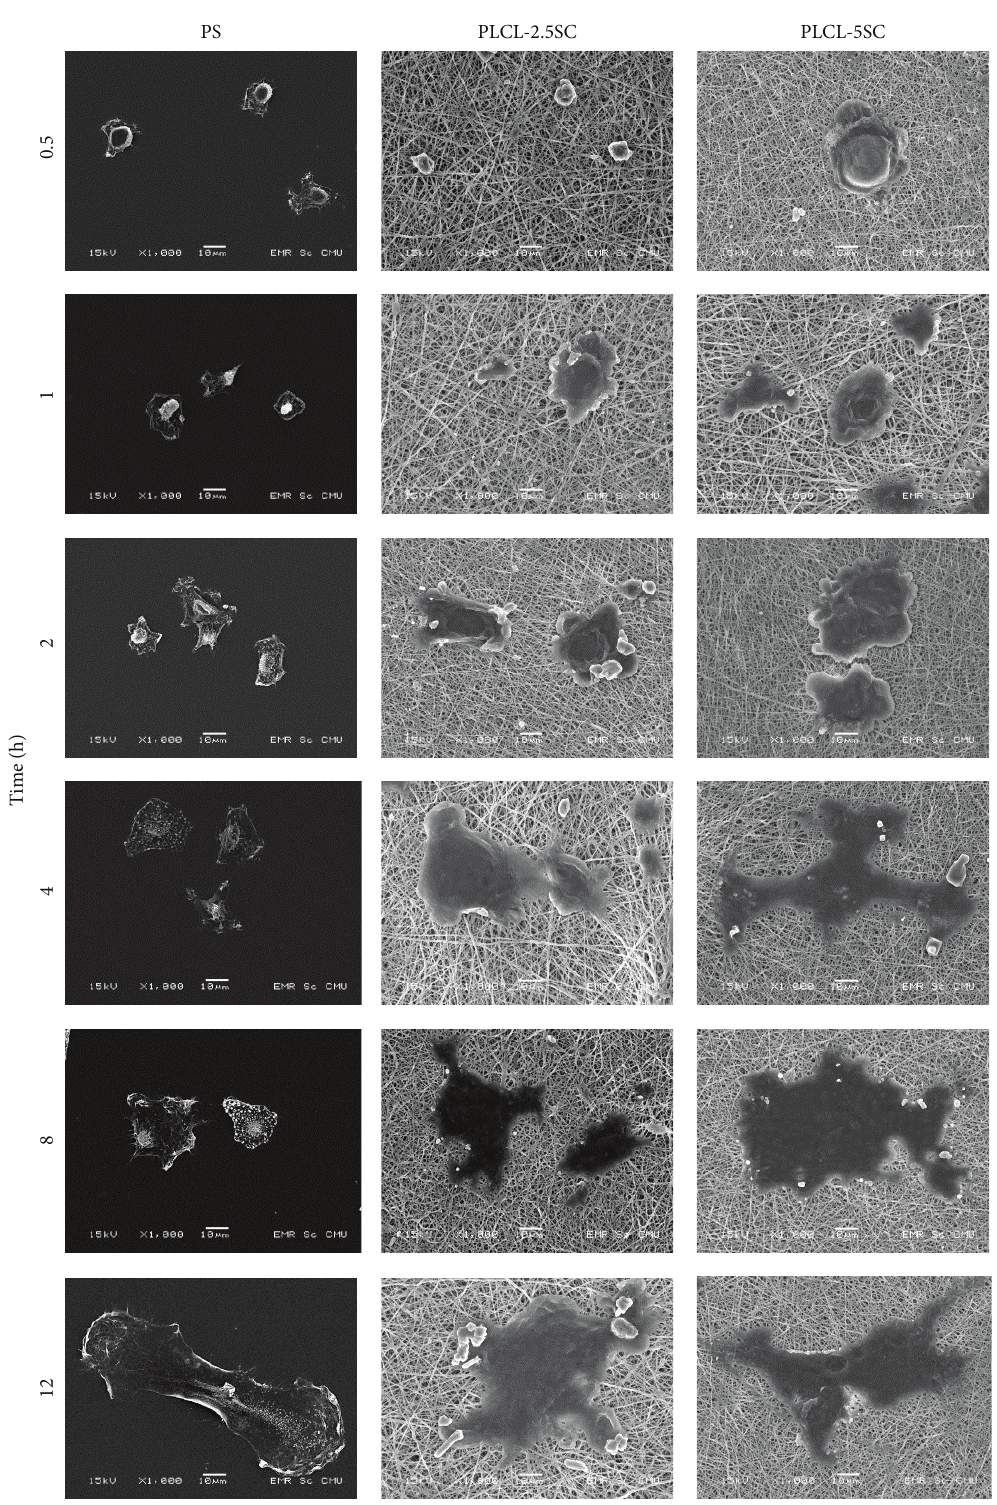
Figure 13: Photomicrographs from SEM showing morphology and attachment patterns of BCP-K1 on PS, PLCL-2.5SC, and PLCL-5SC membranes, cultured at 0.5, 1, 2, 4, 8, and 12 hours. The power of magnification is 1000x at 15 kV (scale bar 10 𝜇